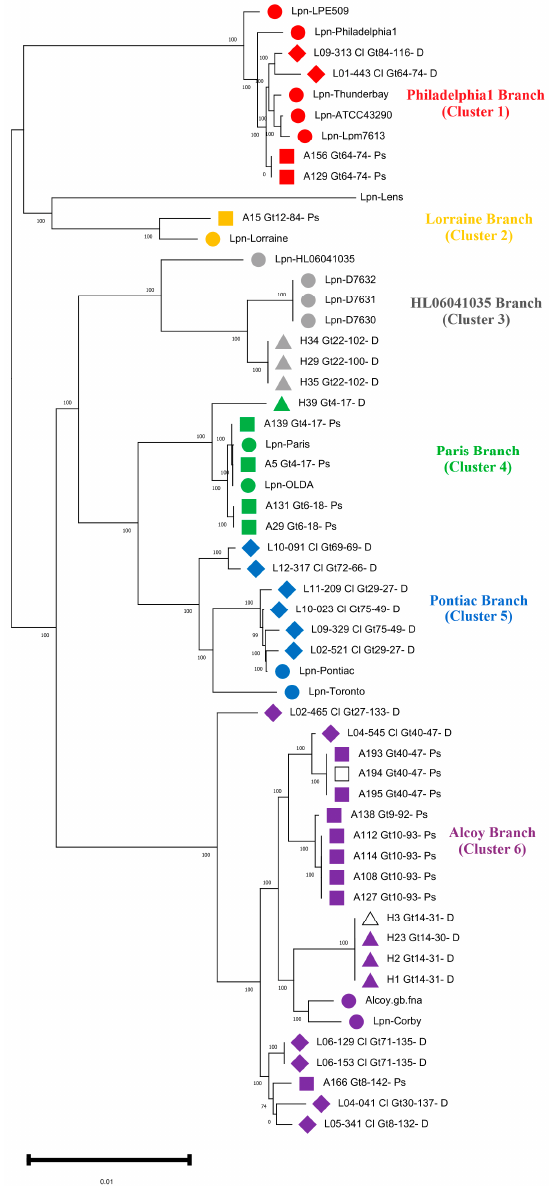
Figure 1. Phylogenomic tree based on Single Nucleotide Polymorphism (SNP) analysis of 55 L. pneumophila genomes. The strains group within six different clusters or branches marked in different colors. As a reference for this phylogenomic tree and to create the core genome L. pneumophila, strain Alcoy was used. Red color indicates isolates assigned to Philadelphia, orange indicates isolates assigned to Lorraine, gray indicates isolates assigned to HL060410035, green indicates iso- lates assigned to Paris, blue indicates isolates assigned to Pontiac and violet indicates isolates as- signed to Alcoy branch. Reference genome from GenBank is indicated with filled symbols. Envi- ronmental isolates from the West Bank are depicted with filled squares. Environmental isolates from Germany (HZI) are indicated with filled triangles, and clinical isolates from Germany are in- dicated with filled rhomboids. The two isolates (A194_Gt40-47-PS and H3_Gt14-31-D) are indi- cated by an empty square and a triangle, respectively, both being sequenced using the PacBio platform.